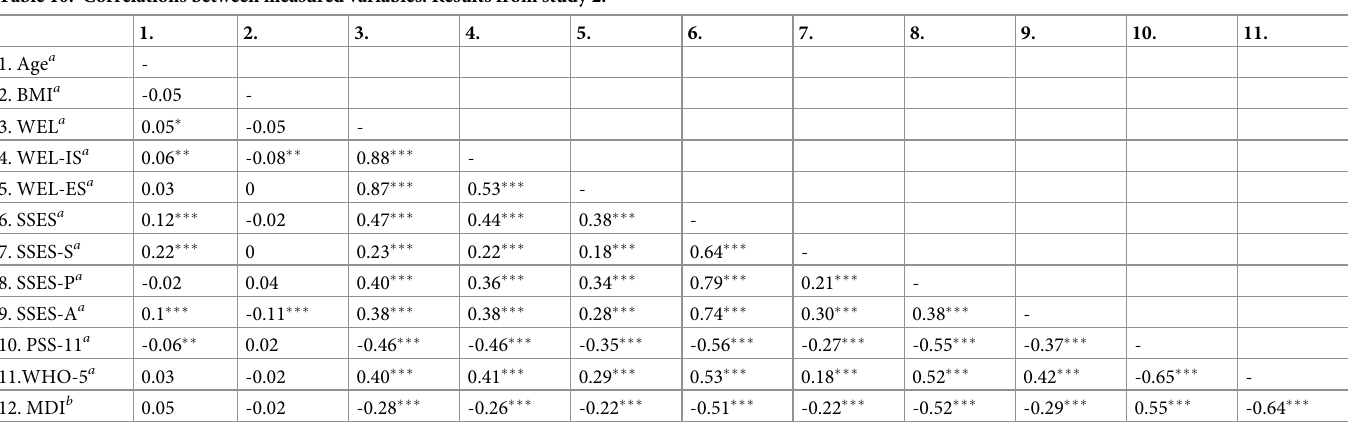
Table 10. Correlations between measured variables: Results from study